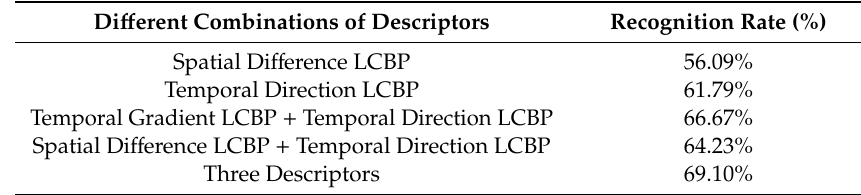
Table 2. Performance comparison between di ff erent combinations of spatial and temporal descriptors on CASME-II. Experiments are conducted without Multi-Regional Joint Sparse